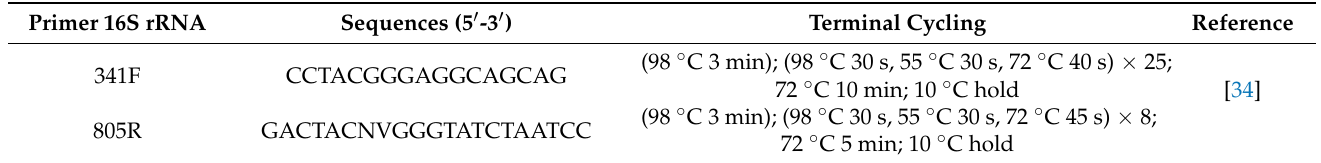
Table 1. Primer combination and thermal cycling conditions used to quantify the 16S rRNA. Primer 16S rRNA Sequences (5 (cid:48) -3 (cid:48) ) Terminal Cycling Reference 341F CCTACGGGAGGCAGCAG 805R